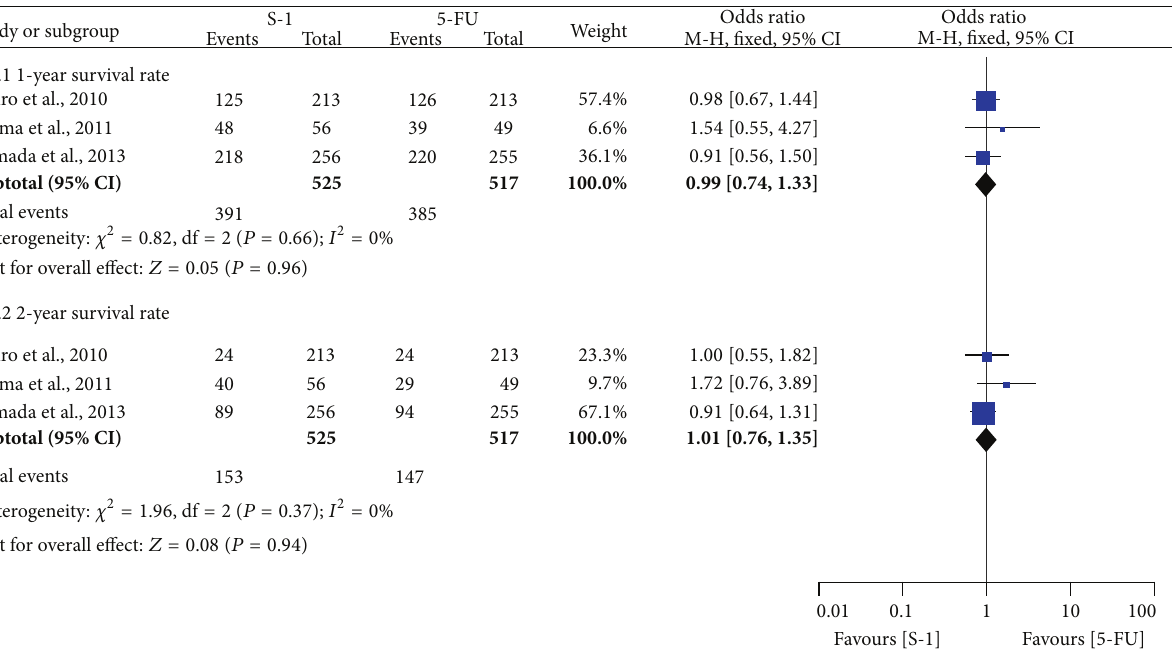
Figure 5: Forest plot of odds ratio of one- or two-year survival